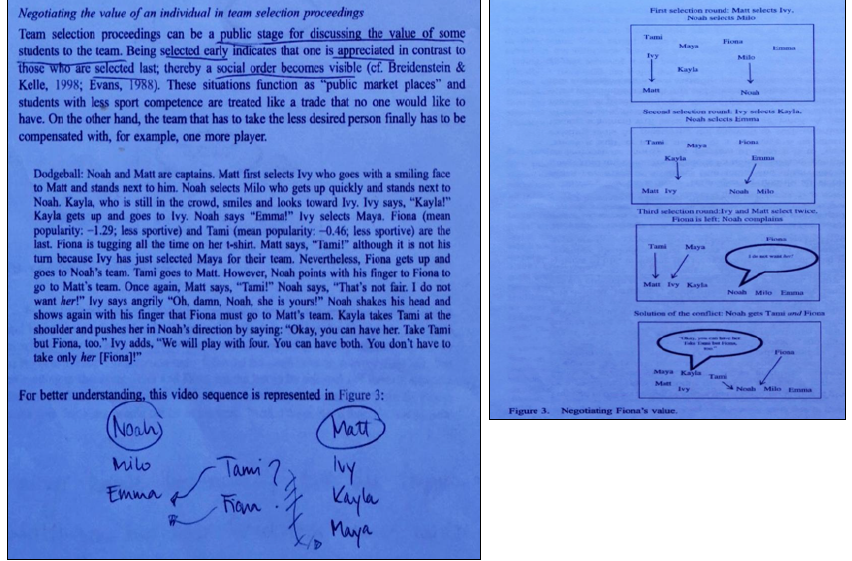
Figure 5. Annotating graphically to unpack dense text (Reprinted from Grimminger 2014, p. 166f.).